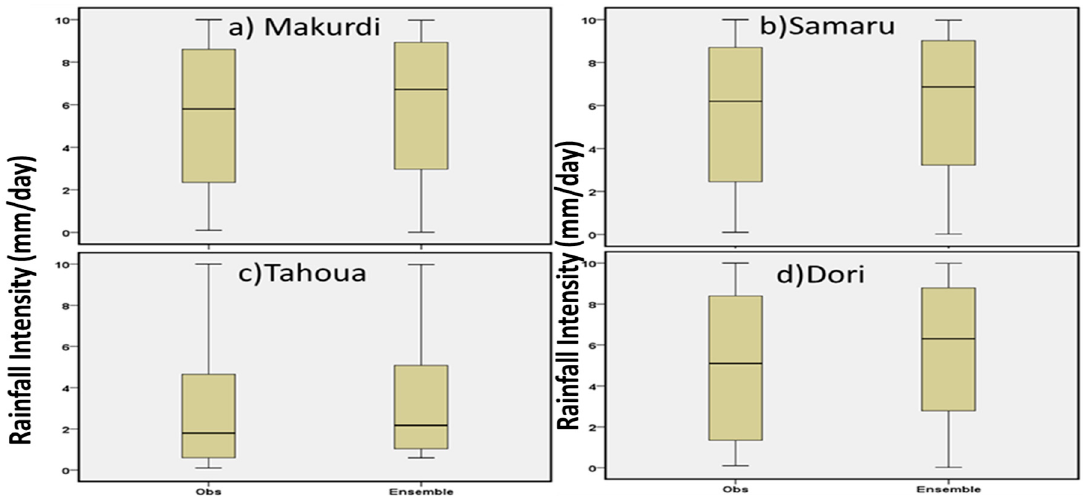
Figure 3. Box and whisker plot comparing the CORDEX multi-models ensemble and observed mean daily low rainfall intensity (>0 to ≤ 10 mm) over the ( a ) Southern (Makurdi) and ( b )Northern (Samaru) Guinea agro-ecological zones and the ( c , d ) Sahelian (Tahoua and Dori) agro-ecological zones for the historical period, 1976/1980–2005 .